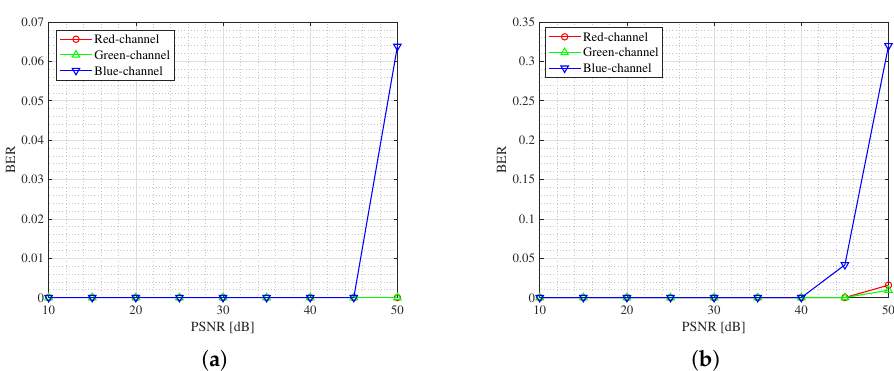
Figure 23. BER Performance according to PSNR for standard images. ( a ) Barbara. ( b )